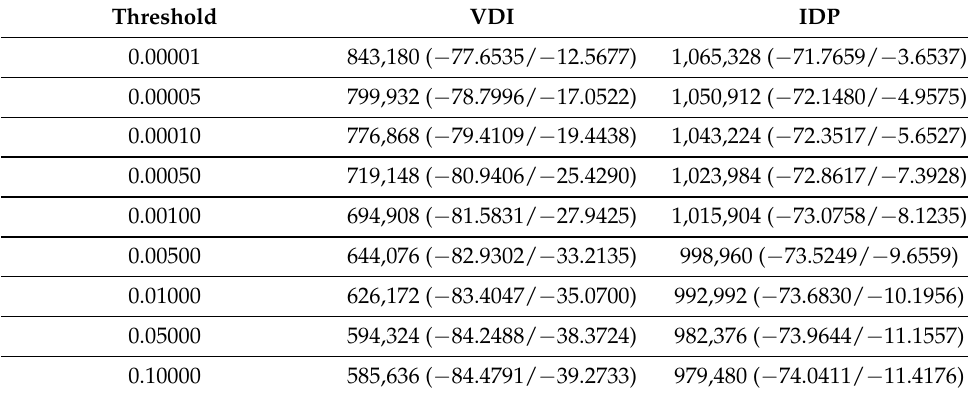
Table 11. diabetes —Global approximation memory size